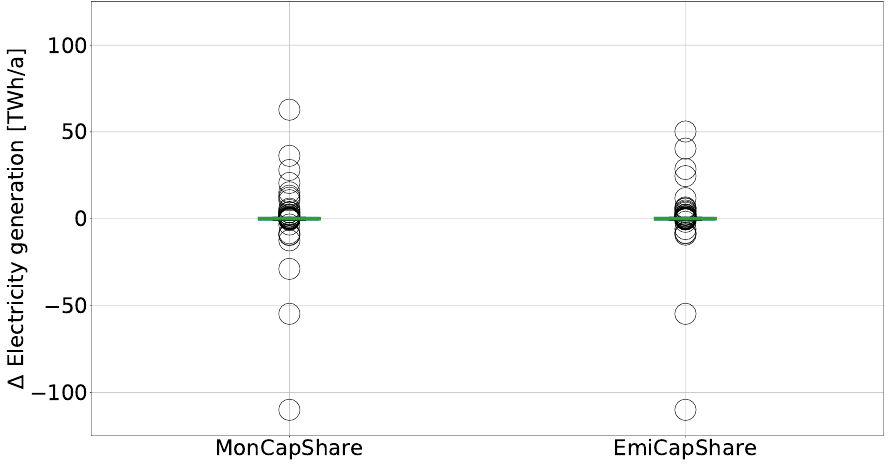
Figure A3. Deviation between CapShare scenarios and real world data for the generated electricity with